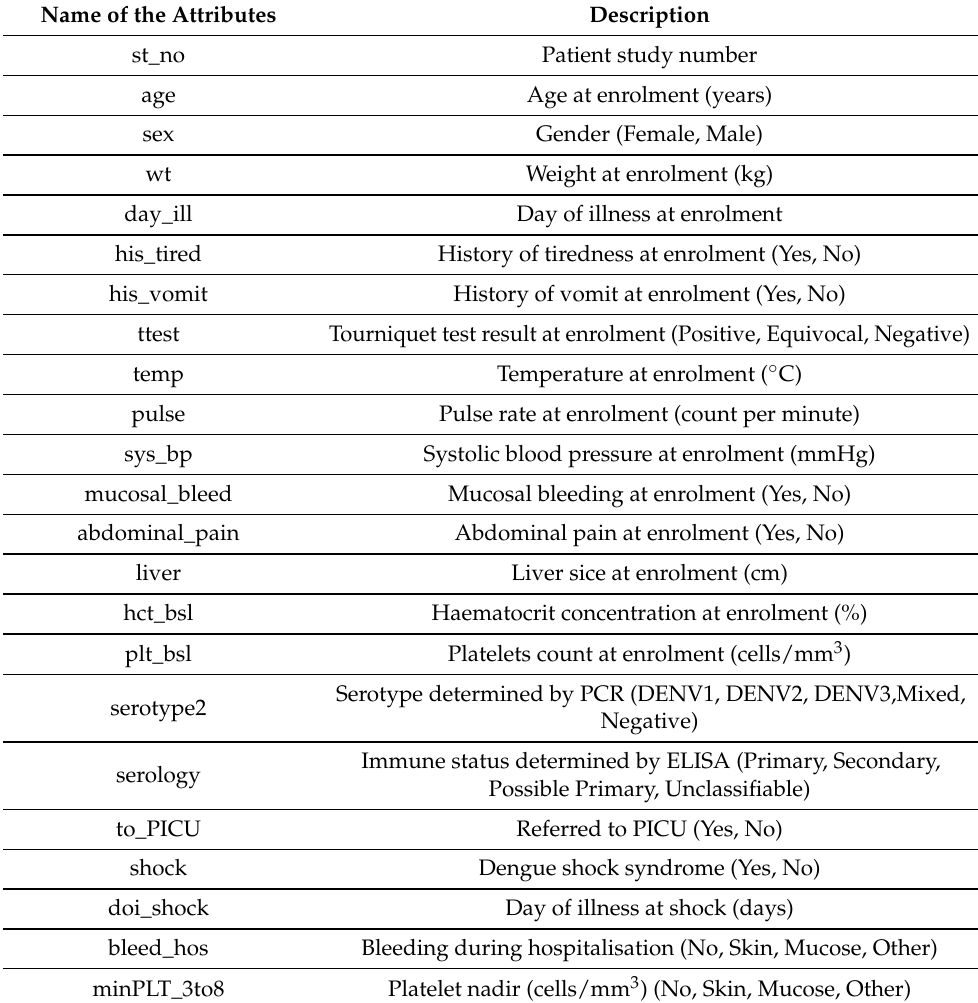
Table 1. Attributes of VDengue